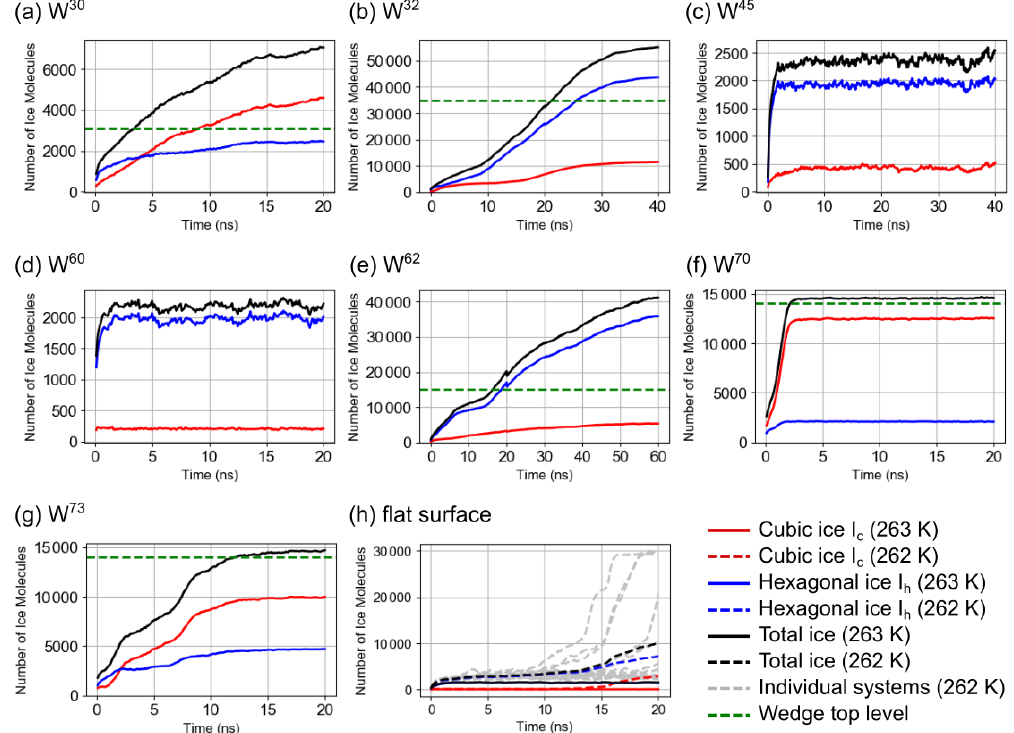
Figure 5. Time evolution of the average number of mW water classified as cubic or hexagonal ice and their sum in wedge systems with different angles at T = 263K (a–g) and on the flat AgI(0001) surface at T = 263 and 262K (h) . Top level indicates when the ice front has grown up to the top of the AgI wedge structure. In some systems, ice growth out of the wedge can be